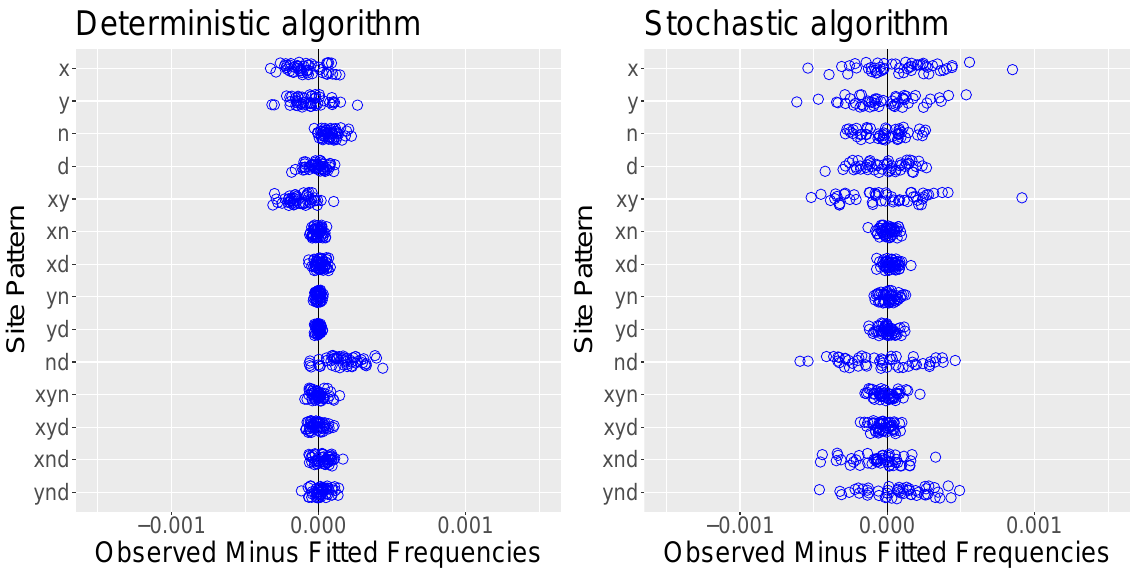
Figure 5 – Residual error of deterministic and stochastic algorithms, based on 50 simu- lated data sets. Each circle refers to a different simulated data set.